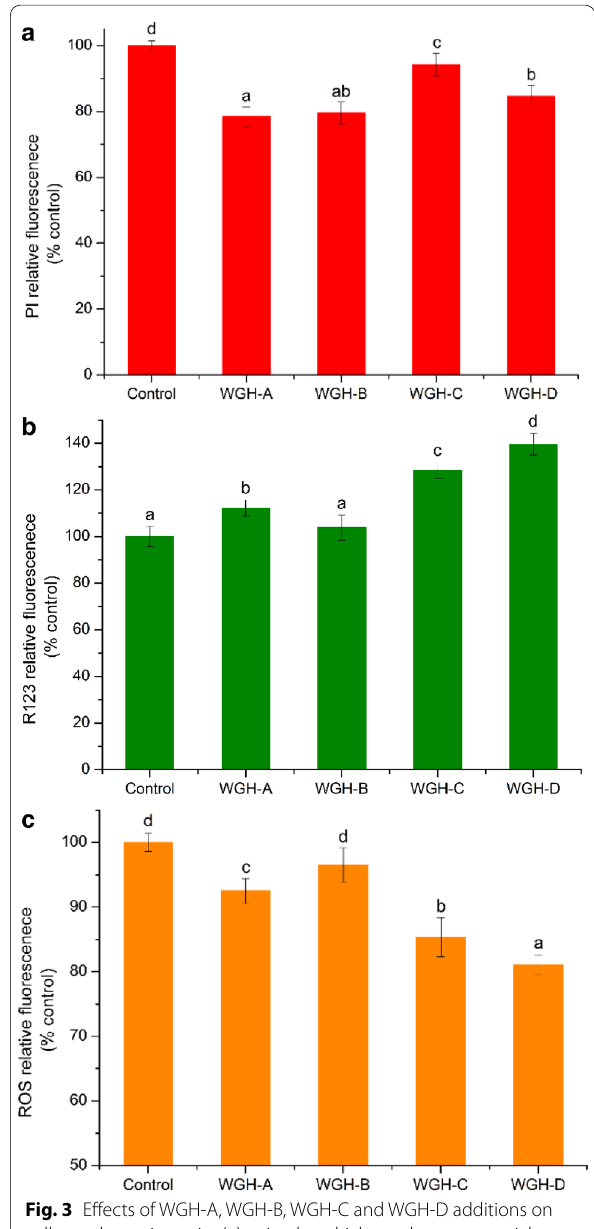
Fig. 3 Effects of WGH-A, WGH-B, WGH-C and WGH-D additions on cell membrane integrity ( a ), mitochondrial membrane potential ( b ) and ROS accumulation ( c ) of yeast cells in exponential phase of VHG worts fermentation. WGH-A, supernatant of wheat gluten hydrolysate; WGH-B, WGH-C and WGH-D, 0, 20 and 40% ethanol elution fractions of WGH-A on XAD-16 resin, respectively. a, b, c, d significant differences between control and samples groups at p <